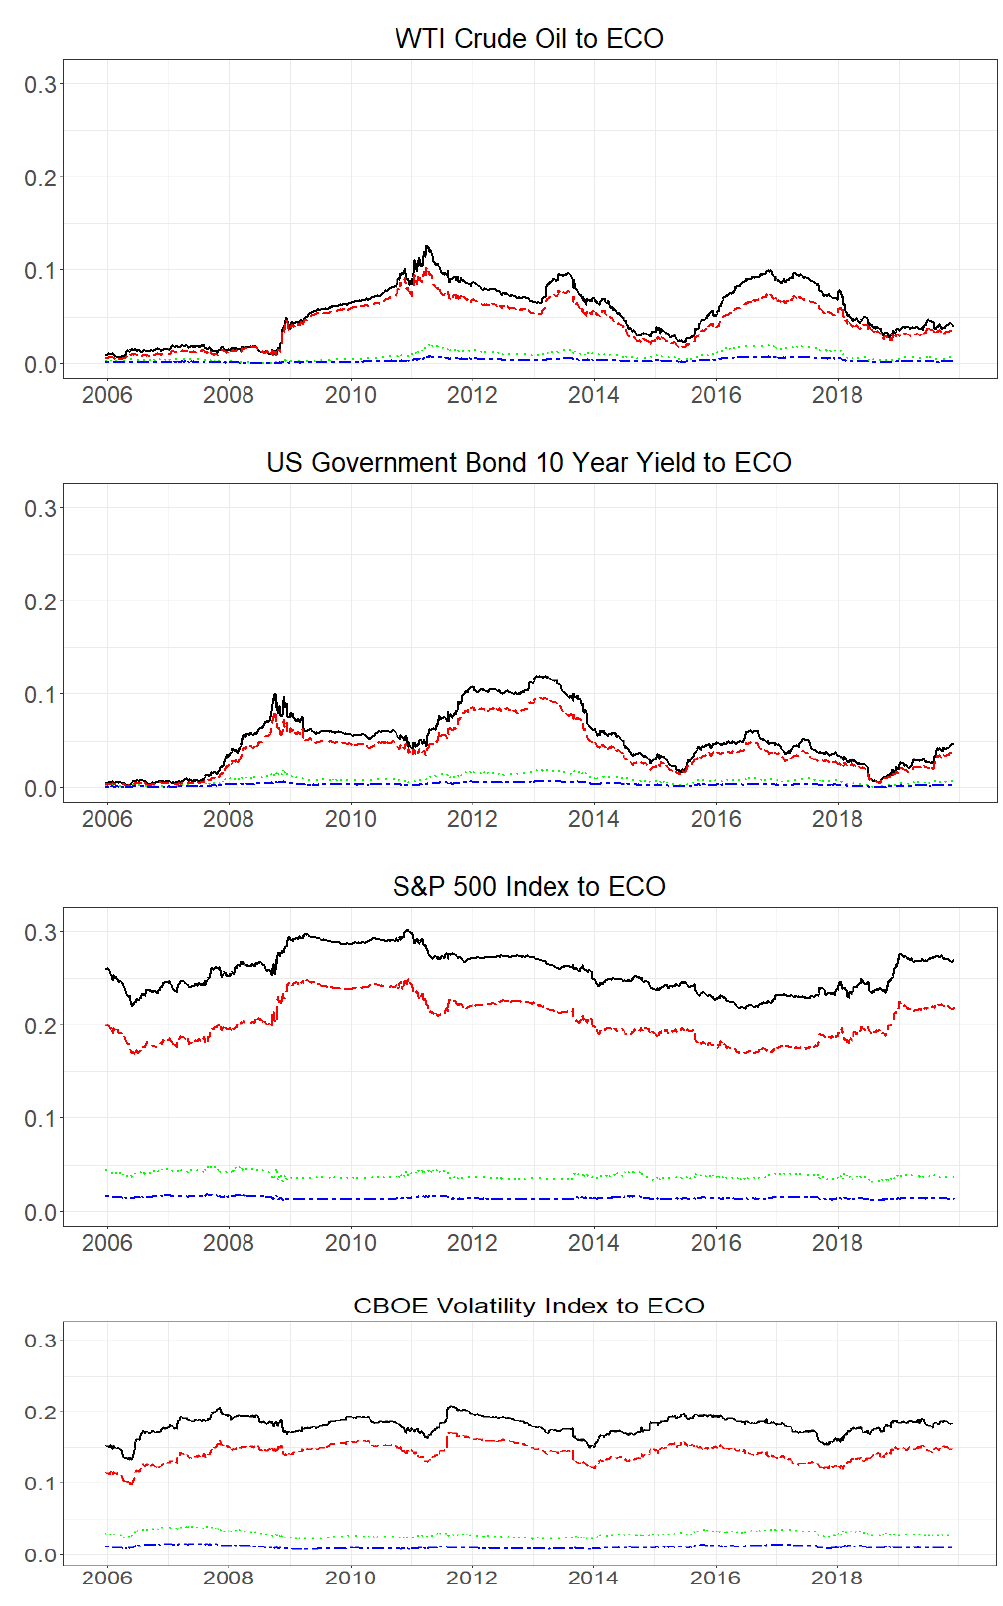
Figure 7. Diebold–Yilmaz [15] directional return spillover (pairwise) and Barunik–Krehlik [16] directional return spillover (pairwise) in the US. Note: ECO indicates the Wilder Hill Clean Energy Index.